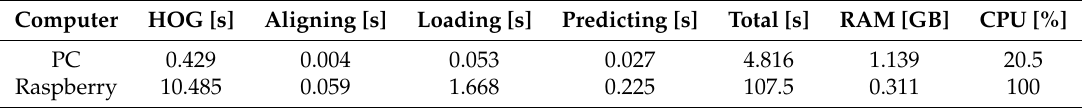
Table 5. Results of resource usage of the NN 40 method averaged from 20 measurements. Columns represents (from left from right): time of HOG face detection, facial image aligning, loading single network model, predicting face feature, total time for processing one acquired frame (including all previous operations) and labelling of all 40 features, RAM memory usage of Python process, and CPU usage of Python